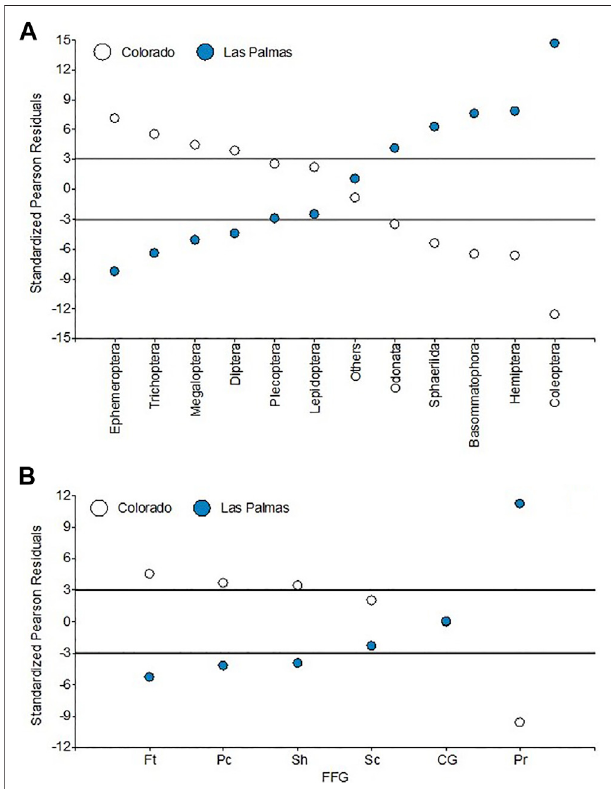
FIGURE 8 | Standardized Pearson residuals for the independence tests for (A) orders and (B) FFG. Lines indicate the standardized Pearson residuals 3 and −